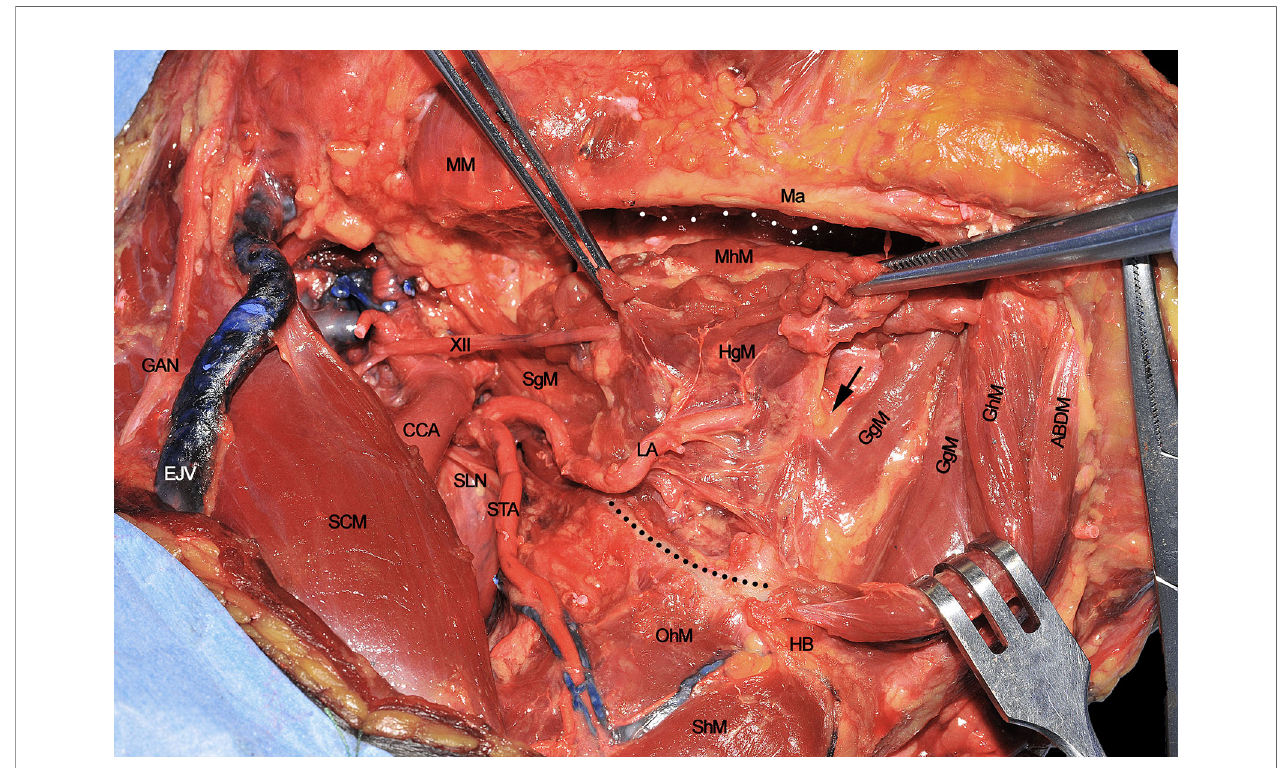
FIGURE 4 | ABDM, anterior belly of digastric muscle; CCA, common carotid artery; EJV, external jugular vein; GAN, great auricular nerve; GgM, genioglossus muscle; GhM, geniohyoid muscle; HB, hyoid bone; HgM, hyoglossus muscle; LA, lingual artery; Ma, mandible; MhM, mylohyoid muscle; MM, masseter muscle; OhM, omohyoid muscle; SCM, sternocleidomastoid muscle; SgM, styloglossus muscle; ShM, sternohyoid muscle; SLN, superior laryngeal nerve; STA, superior thyroid artery; XII, hypoglossal nerve. White dotted line, mylohyoid line of the mandible. Black dotted line, great hyoid cornu. Black arrow, paramedian septum of the